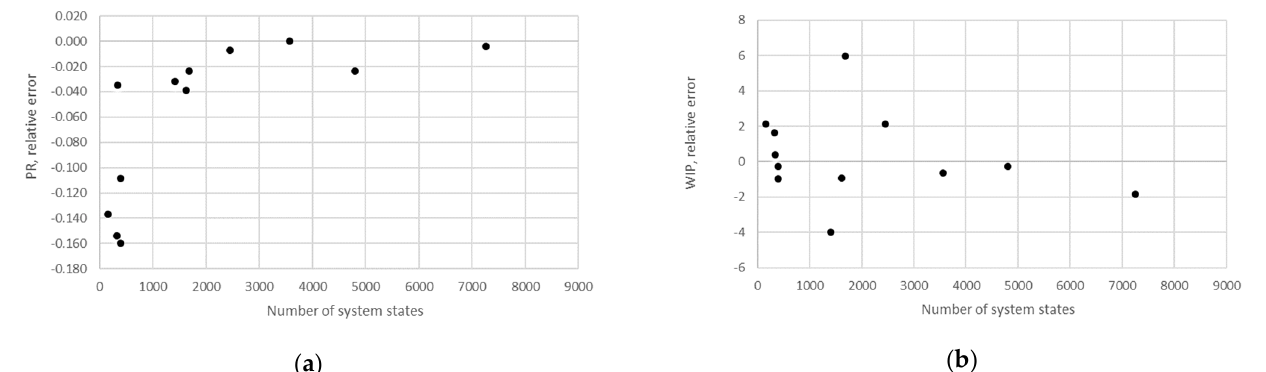
Figure 24. M = 5, relative error obtained using the numerical method—( a ) PR and ( b ) WIP.